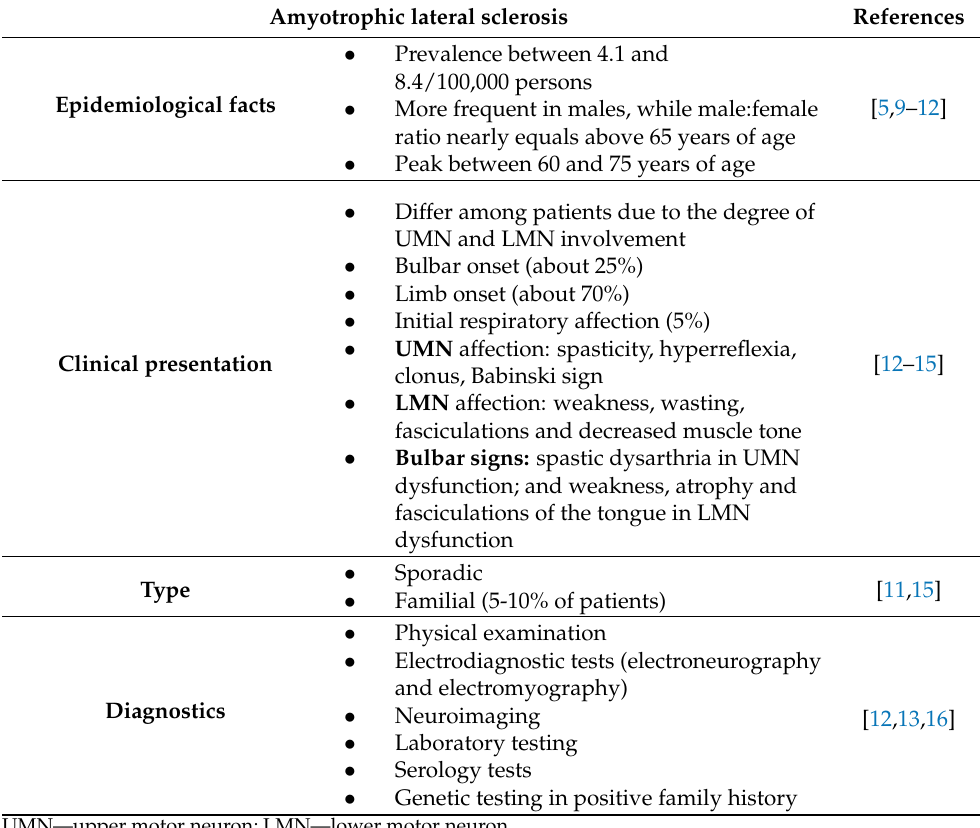
Table 1. Amyotrophic lateral sclerosis quick